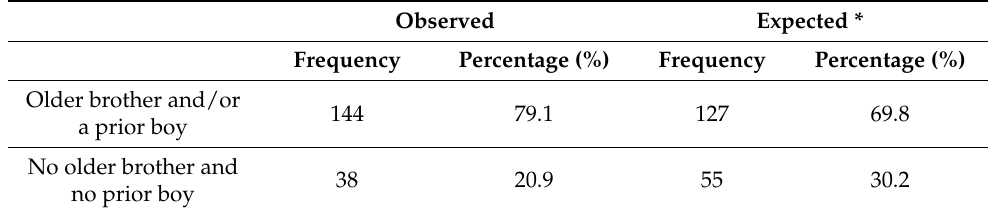
Table 5. The observed and expected distribution of siblings and previous births in all sRPL patients according to sex. All previous births before sRPL were included ( n =